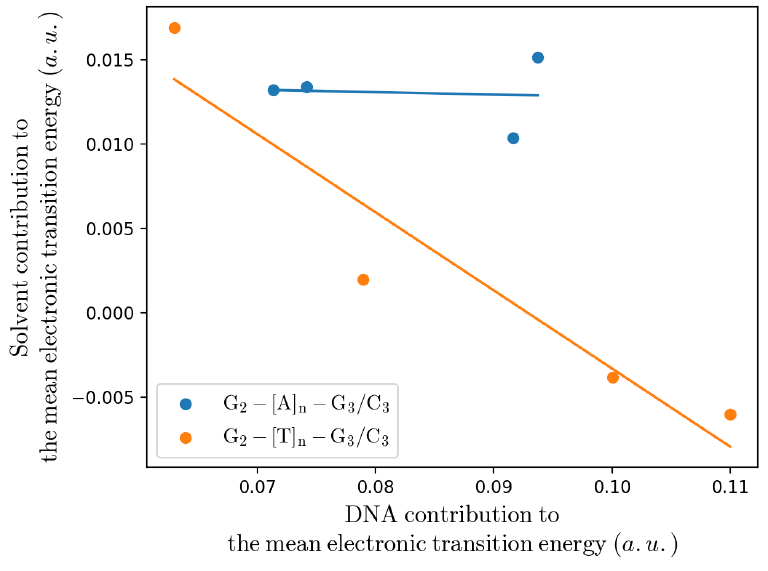
Figure 7. Solvent contribution to the mean electronic transition energy versus the DNA contribution to the mean electronic transition energy. Note that larger DNA contributions correspond to larger bridge lengths and in the T-type bridge systems only for the inter-strand CT the solvent contribution (the highest value) is comparable to the solvent contributions of the A-type bridge systems. The solid lines are the linear regressions of the data.